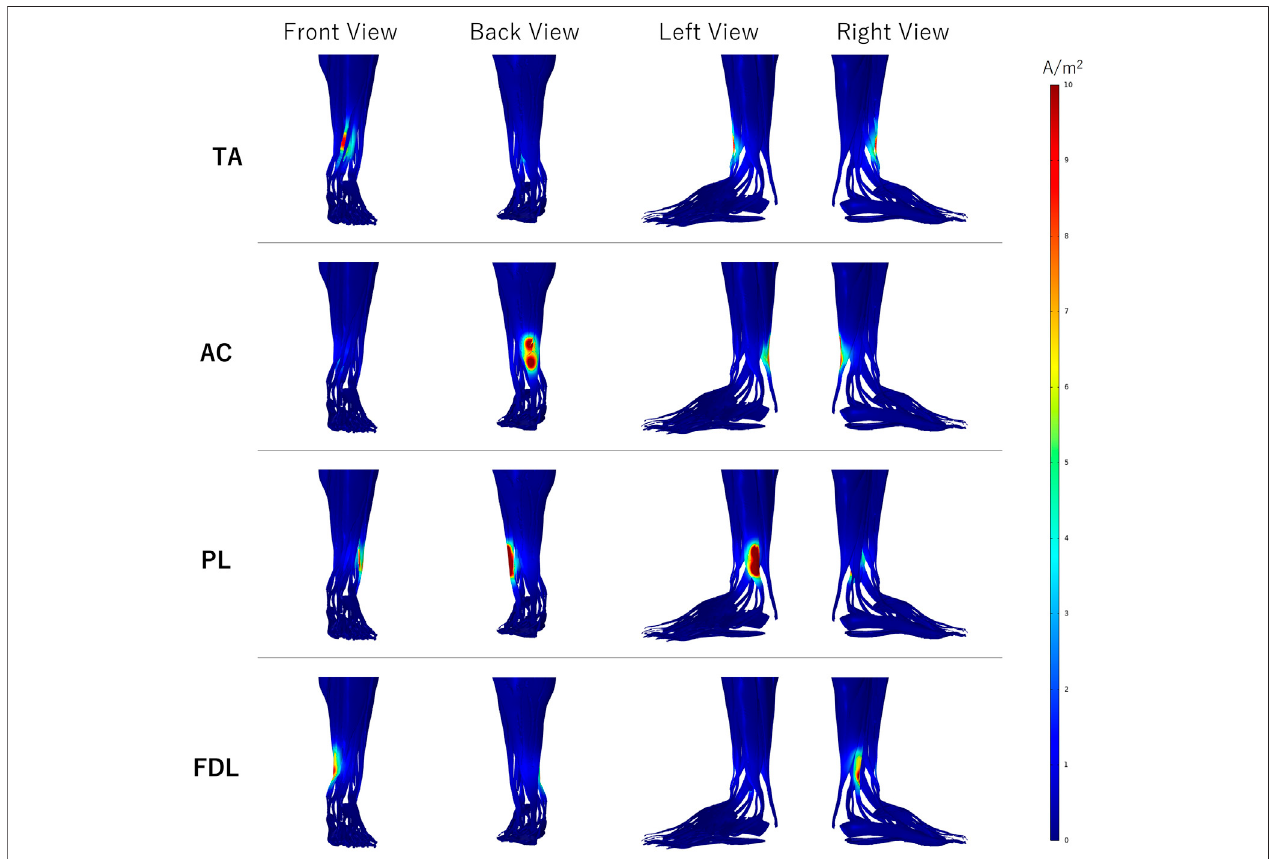
FIGURE 3 | Distributions of the current density in the simulations.